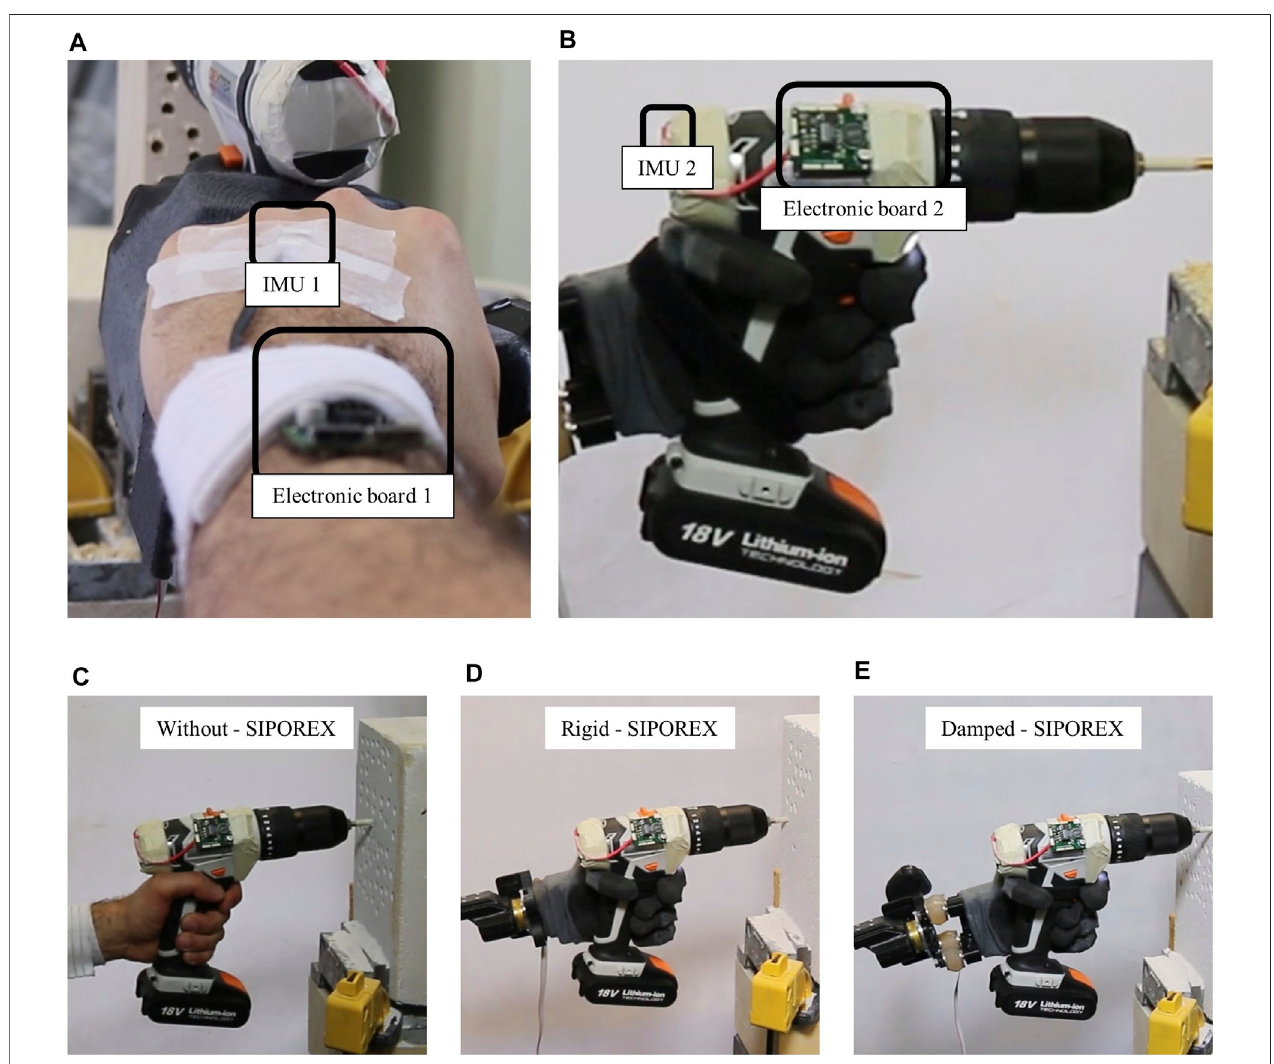
FIGURE4|(A,B) TheIMUsandtheelectronicboardsforrecordingtheaccelerationonboththehandandthedrill. (C – E) The drillingin phasewiththeSIPOREX,for the without , rigid , and damped con fi gurations, respectively.